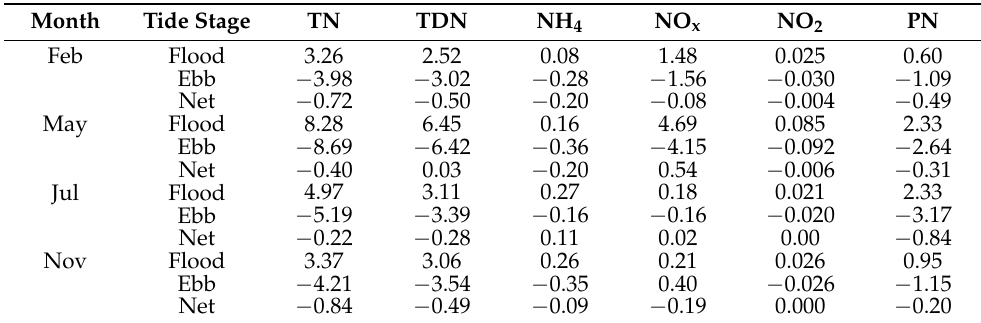
Table 3. Fluxes (kg/tidal cycle) of measured N constituents in Cell 1B during 2014 deployments. Negative values represent tidal export.